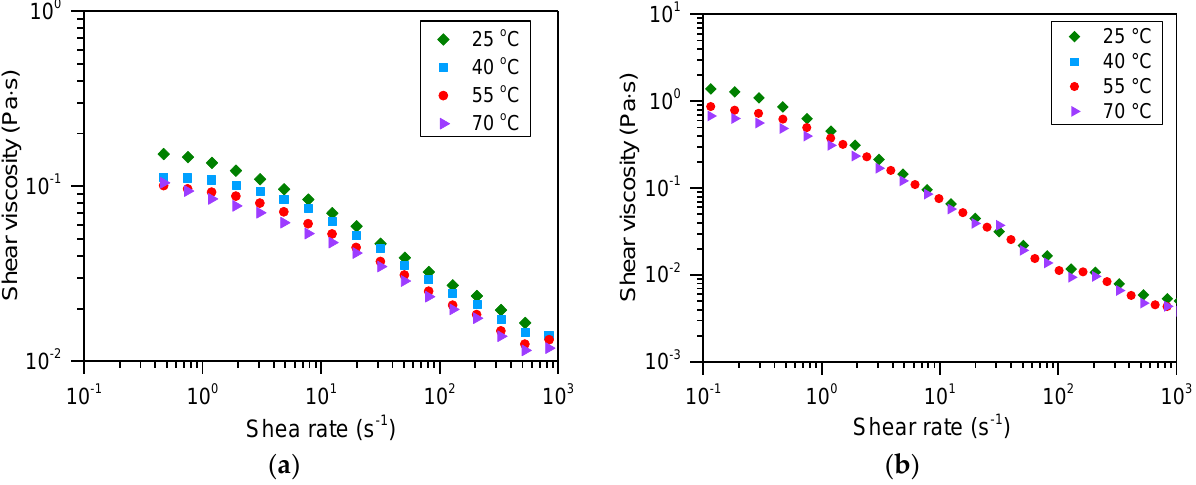
Figure 8. Shear viscosity of ( a ) HPAM and ( b ) the biopolymer solutions at different temperatures (2 wt% NaCl).